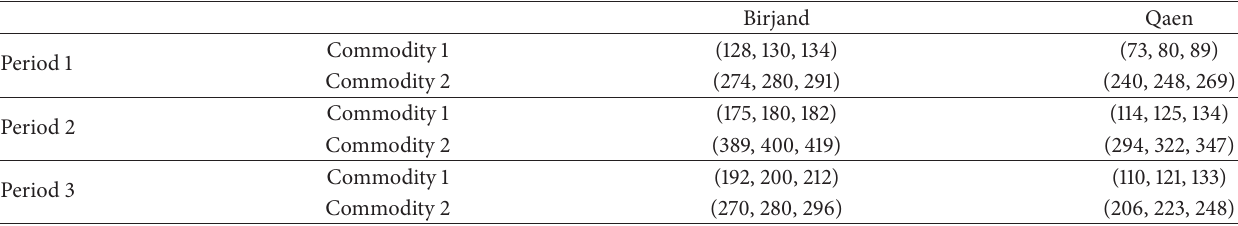
Table 14: The amount of inventory in established distribution centers ( ∗